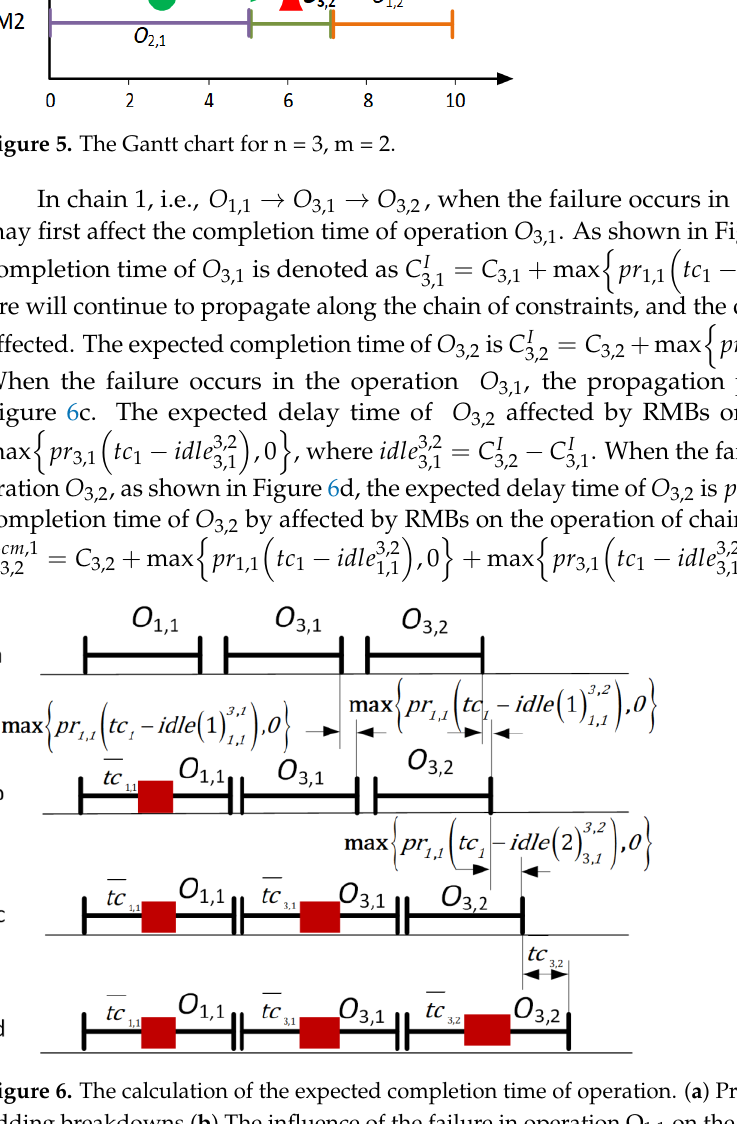
Figure 6. The calculation of the expected completion time of operation. ( a ) Process sequence without adding breakdowns ( b ) The influence of the failure in operation O 1,1 on the completion time of the subsequent operations. ( c ) The influence of the failure in operation O 3,1 on the completion time of the subsequent operations. ( d ) The influence of the failure in operation O 3,3 on its own completion